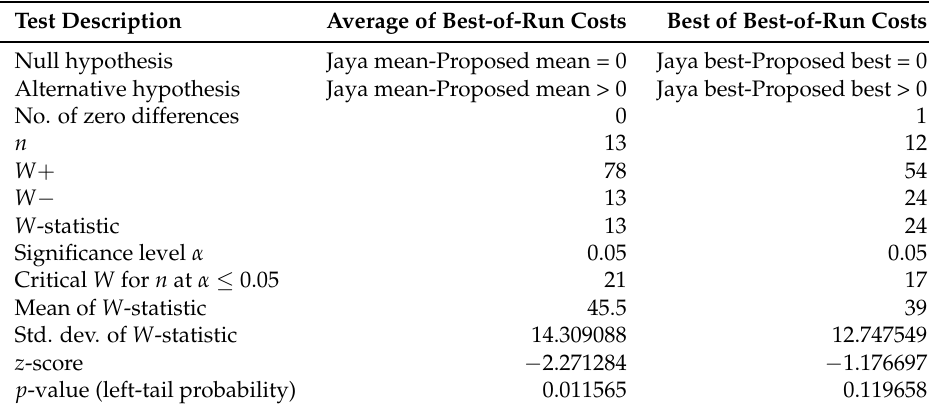
Table 6. Wilcoxon signed rank tests on the data in Table 4 (sample size =